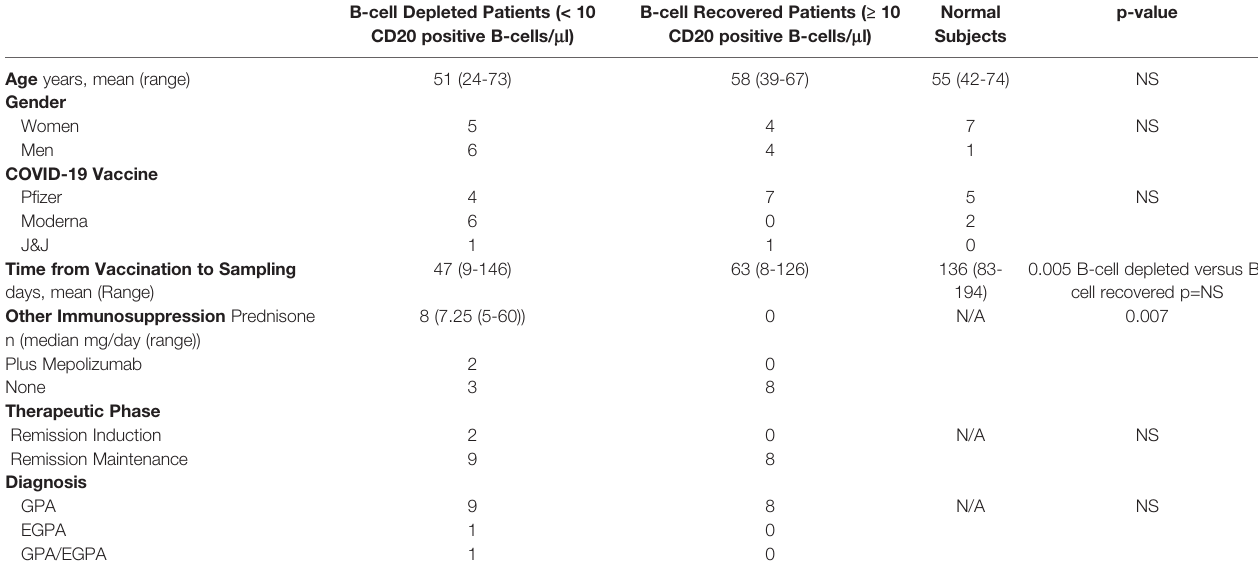
TABLE 1 | Subject